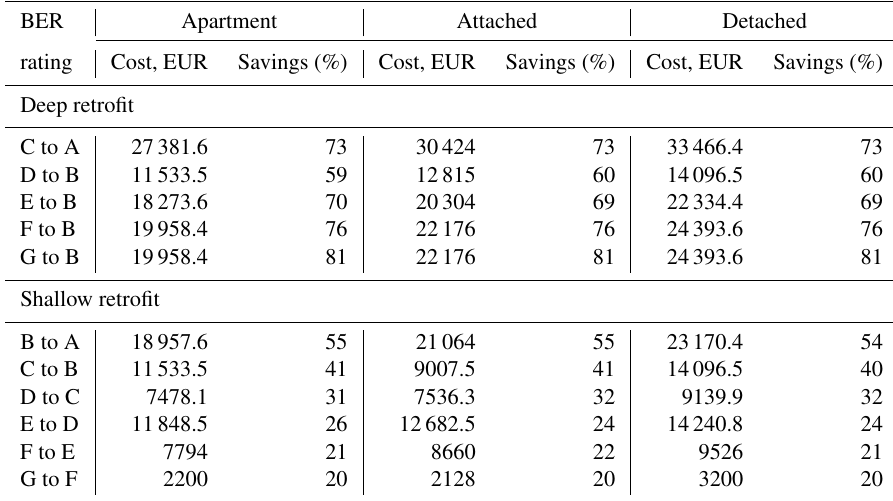
Table 10. Retrofit cost and expected savings.